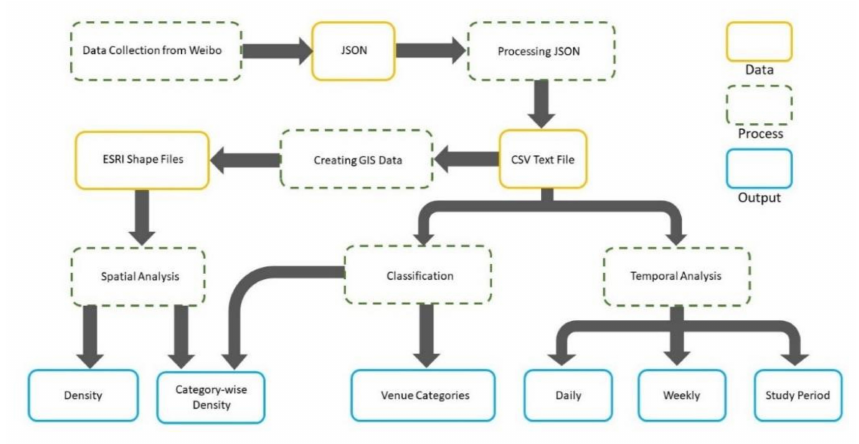
Figure 2. Research